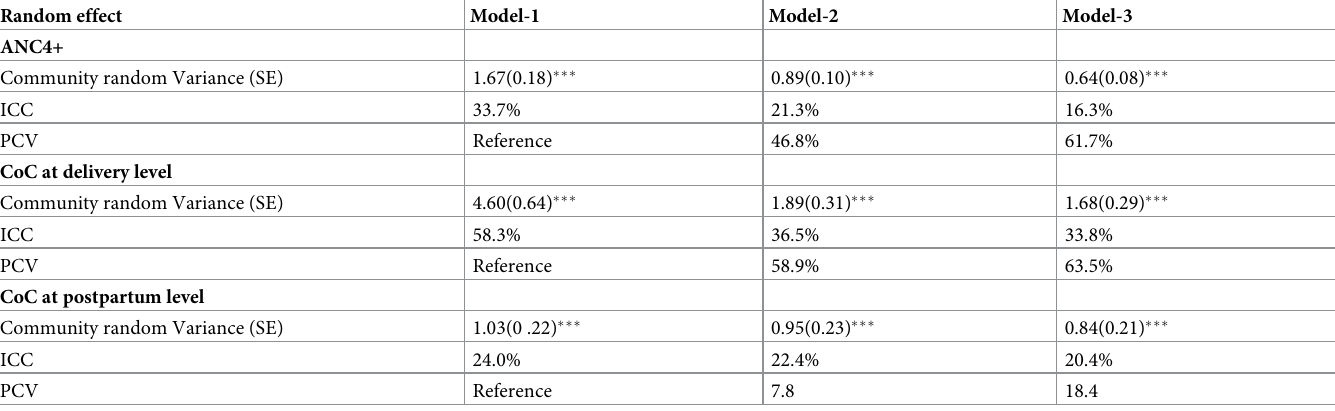
Table 4. Random effect estimates of multilevel model for each outcome variable.